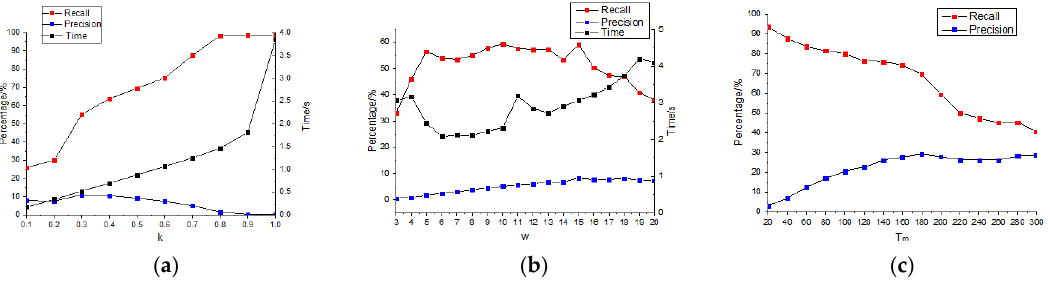
Figure 7. The crack detection results after adjusting: ( a ) k , ( b ) w ( σ ) ; ( c ) T m In the multi-scale space fusion of w = 5 − 15 ( σ ∊ (1.45, 4.33)), adjust the parameter k in Equation